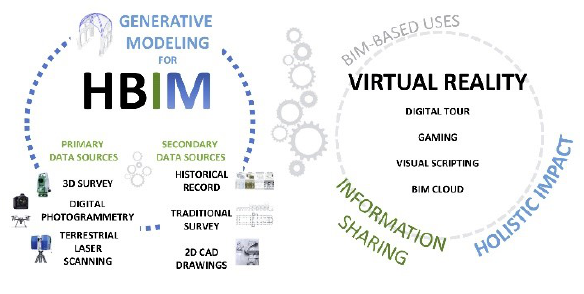
Figure 3. The research objective and the generative workflow applied to the research case